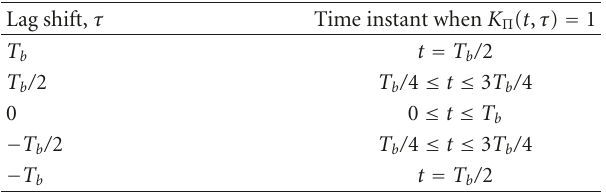
Table 5: Instantaneous autocorrelation function of the box func- tion. Lag shift, τ Time instant when K Π ( t , τ ) =